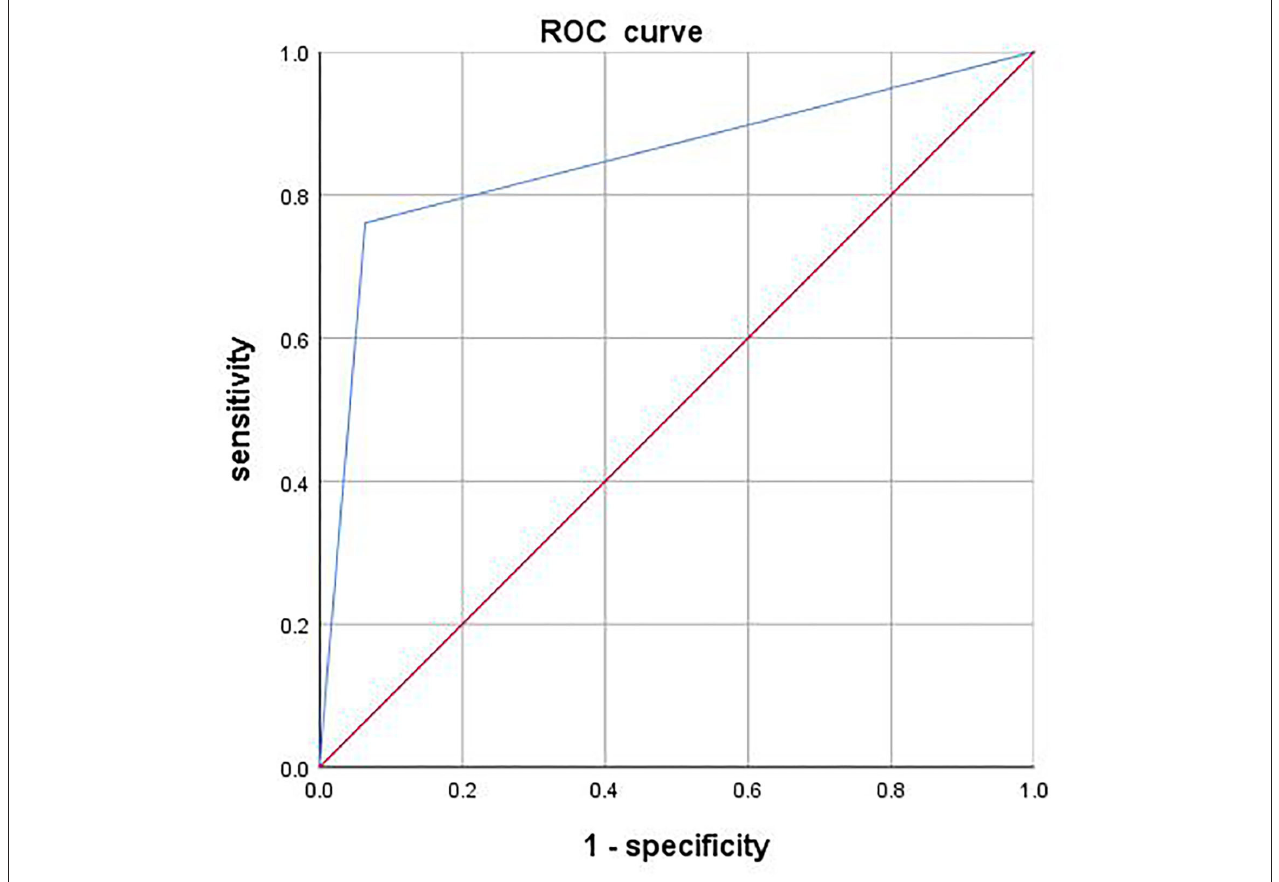
FIGURE 1 | Clinical diagnostic efficacy of the rating questionnaire for screening and early warning of cervical